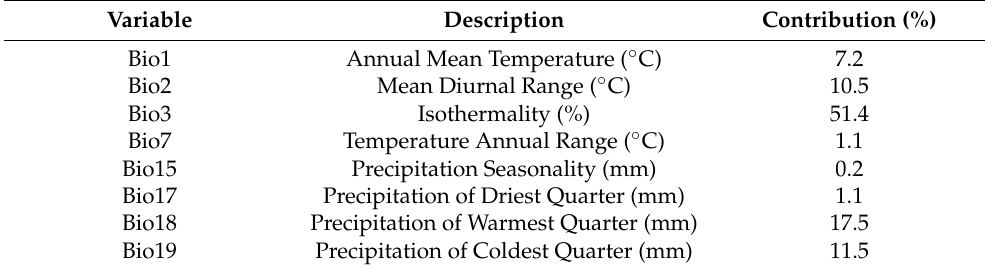
Table 1. Selected bioclimatic variables and their contribution rate to the model. Variable